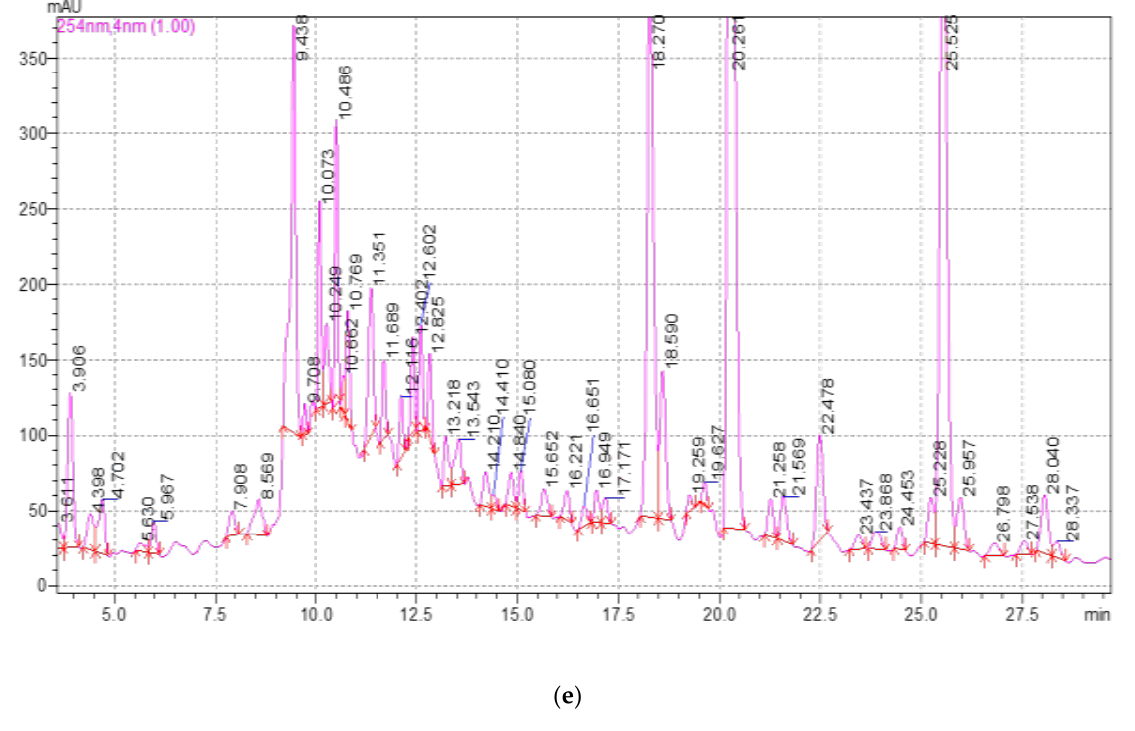
Figure 5. Chromatograms of extracts of different extraction times with ultrasonic treatment: ( a ) 10